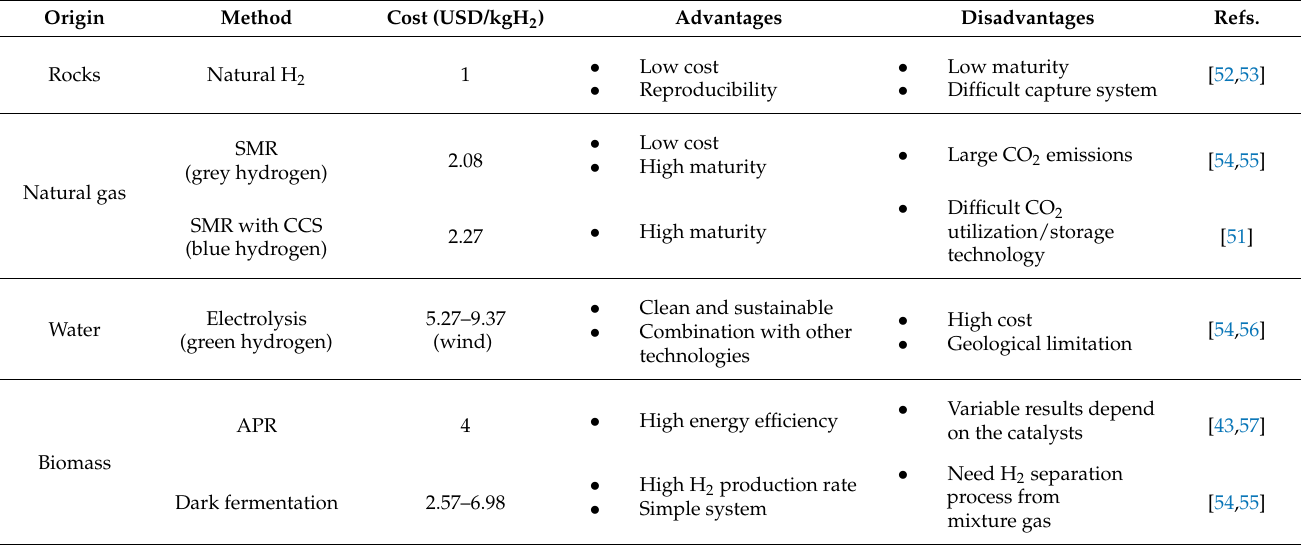
Table 4. Costs of various hydrogen production technologies (reprinted with permission from ref. [51] Copyright 2022